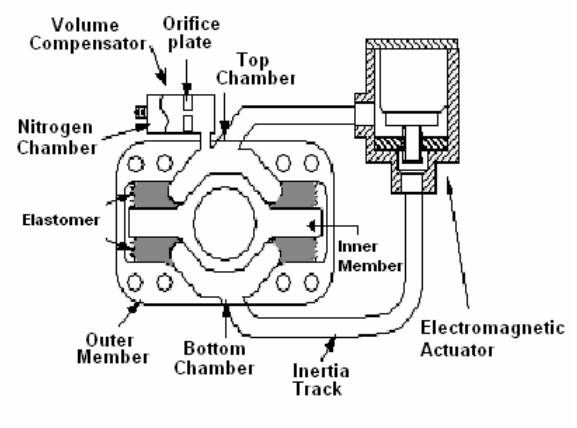
Fig. 7. A double pumper active fluid mount.